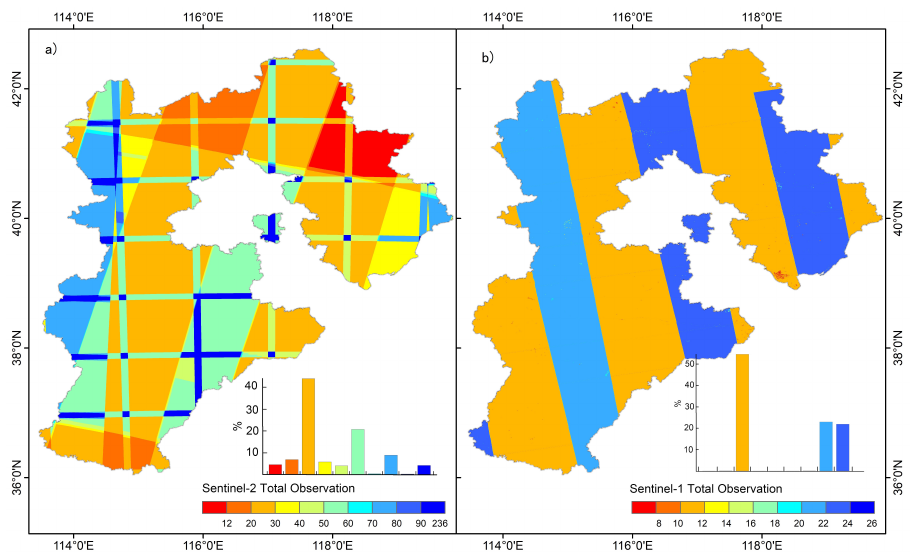
Figure 3. Total observation numbers of ( a ) Sentinel-2 and ( b ) Sentinel-1 images acquired between 1 June and 31 October 2017, in Hebei Province. The embedded histograms depict the distribution of the number of Sentinel images with different color bars, and the color is same as the map legends.